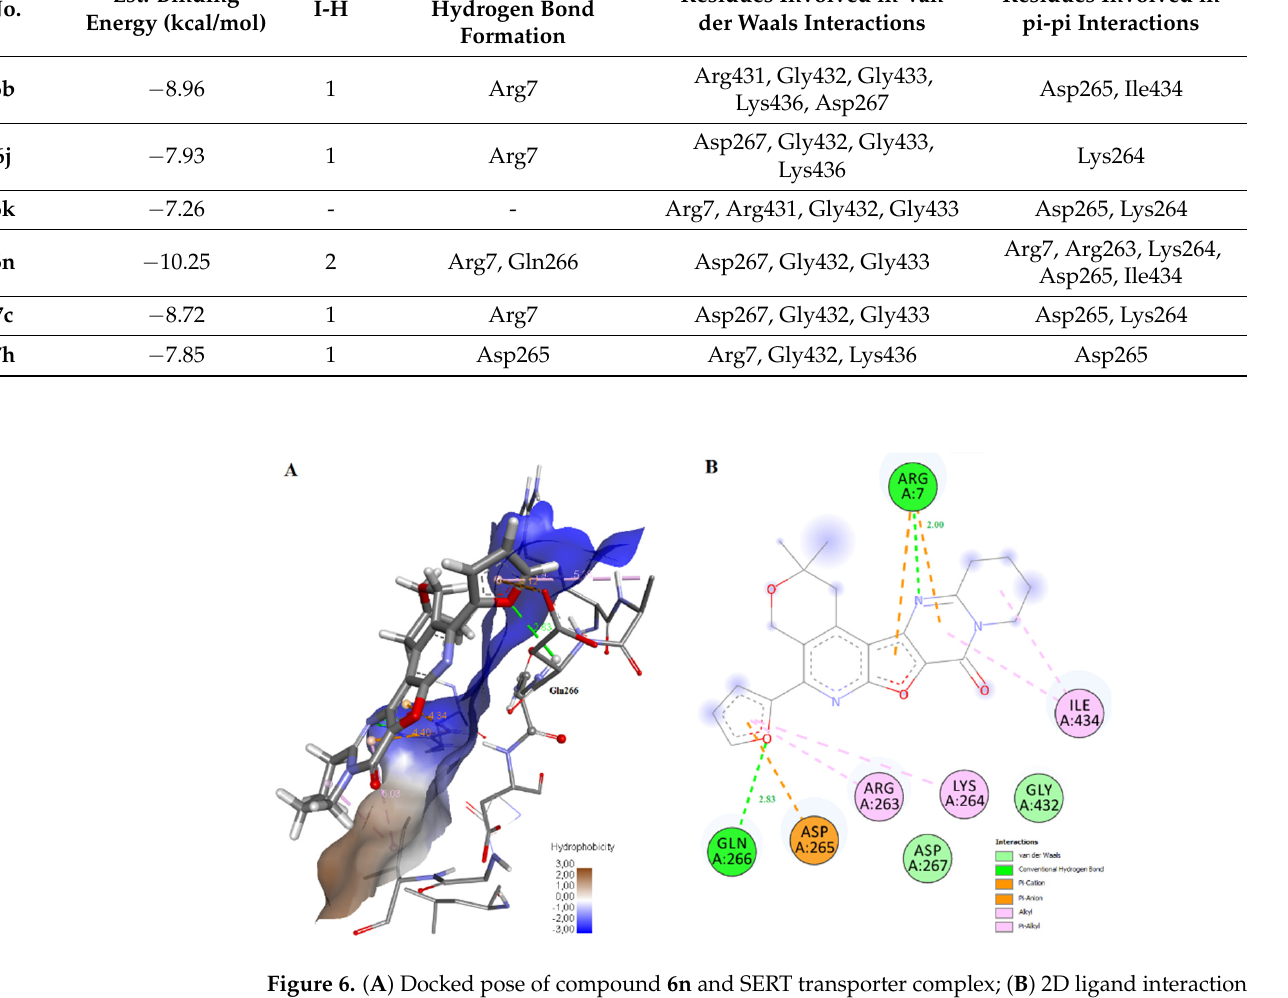
Figure 6. ( A ) Docked pose of compound 6n and SERT transporter complex; ( B ) 2D ligand interaction diagram for docked ligand.